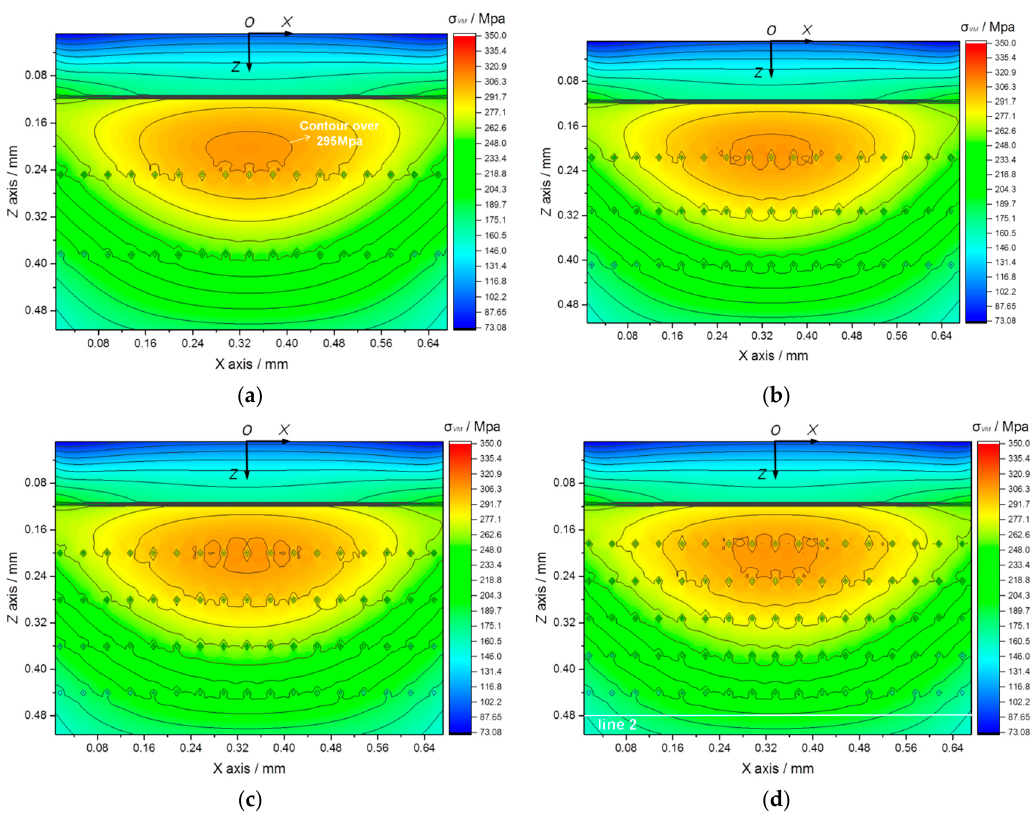
Figure 25. Von Mises stress fields in cross section XOZ with increasing numbers of reinforcing SiC fiber rows: ( a ) 2 rows, ( b ) 3 rows, ( c ) 4 rows, and ( d ) 5 rows.